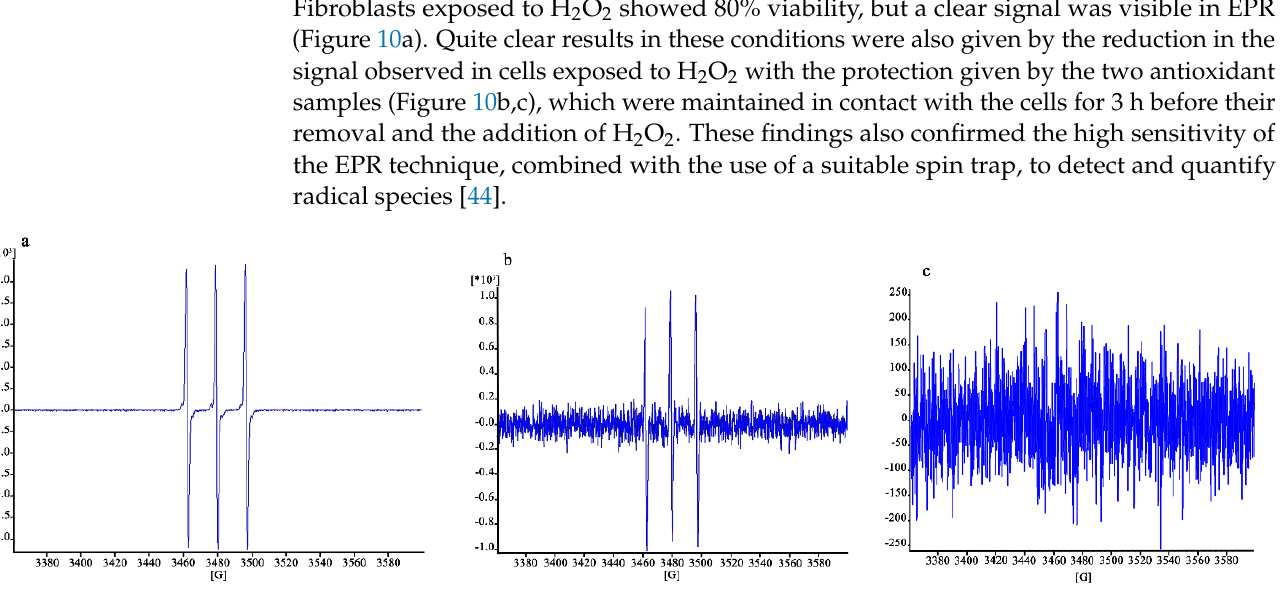
Figure 10. EPR signal due to the ROS inside the cells damaged after exposure to H 2 O 2 without previous treatment ( a ) and with treatment with CSO–CO 100 (1:20 ( v / v )) ( b ) or α -tocopherol (10 µ M) encapsulated in CSO ( c ).